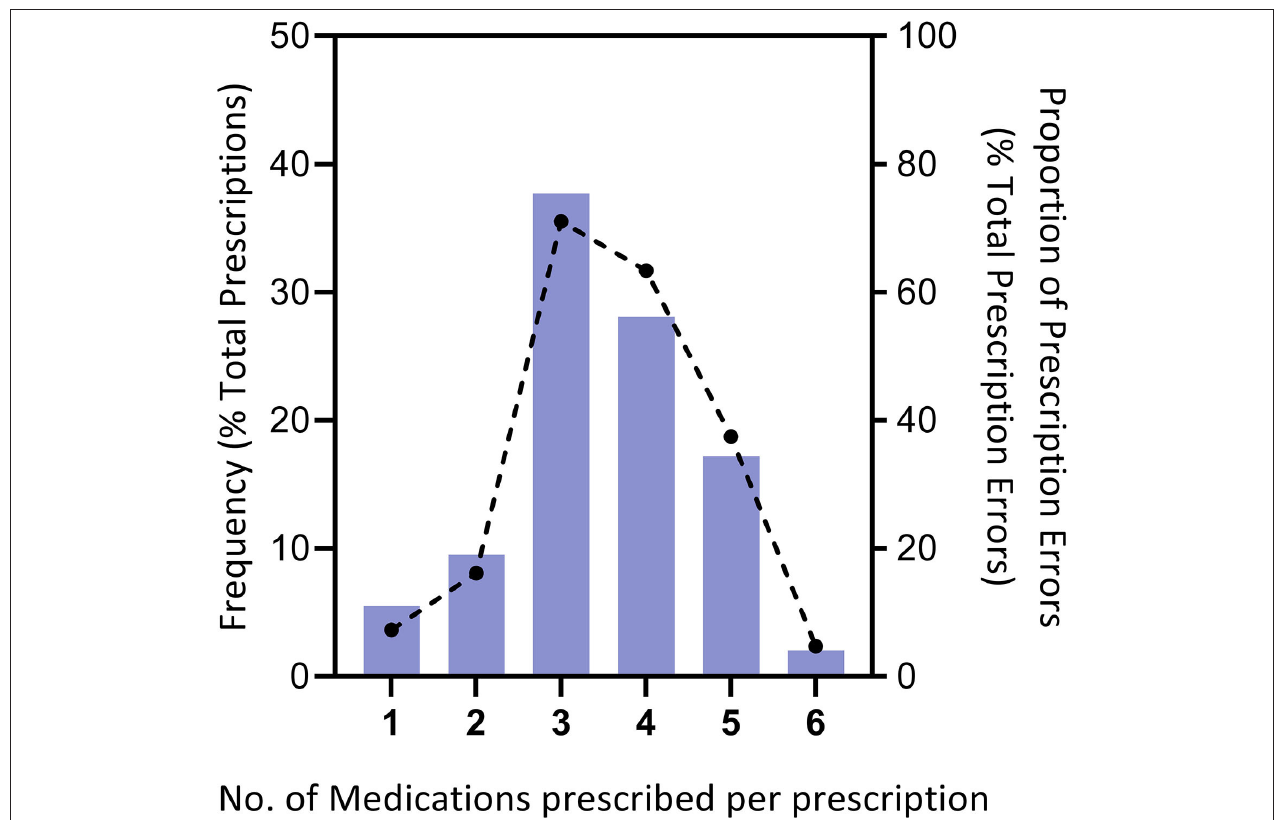
FIGURE 1 | Distribution of prescriptions and errors per primary-care visit. The number of medications prescribed per patient visit ( n = 1,724 patient visits)is approximately the proportion of prescription errors divided by the total prescription errors (total = 2890